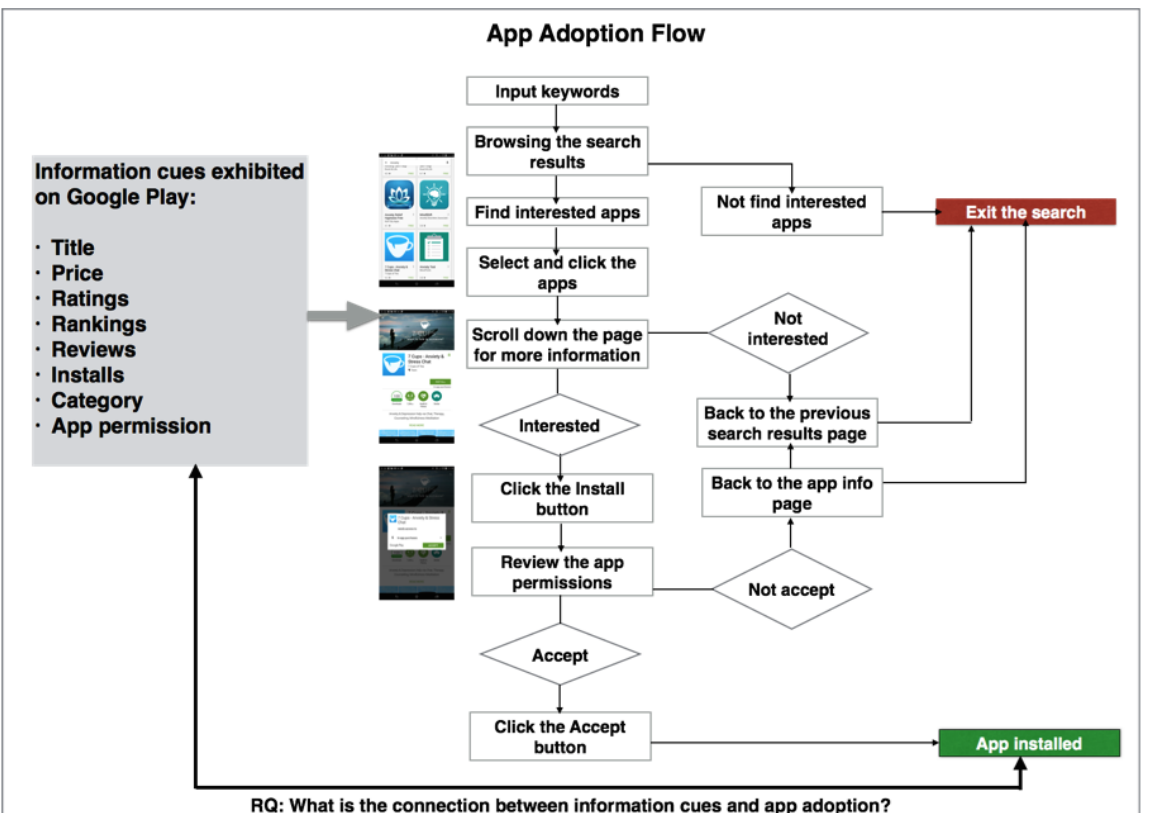
Figure 1. Research